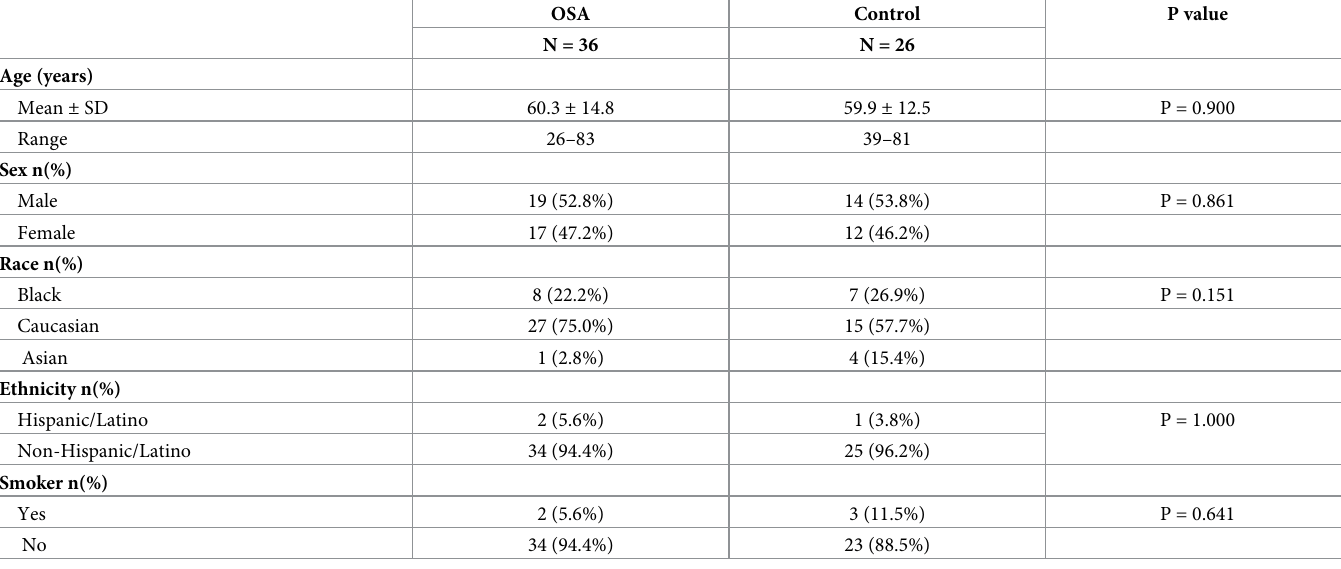
Table 1. Patient